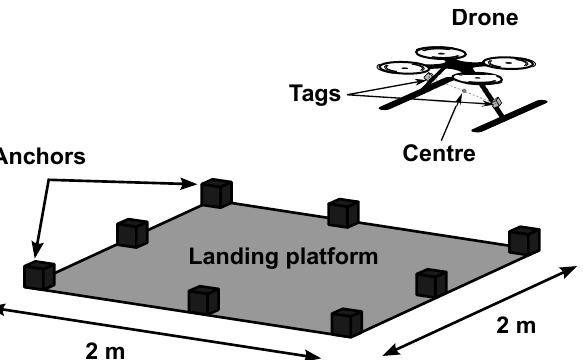
Figure 2. Proposed system architecture. Eight anchors are placed around the landing platform in order to locate the tags on the drone in real-time.